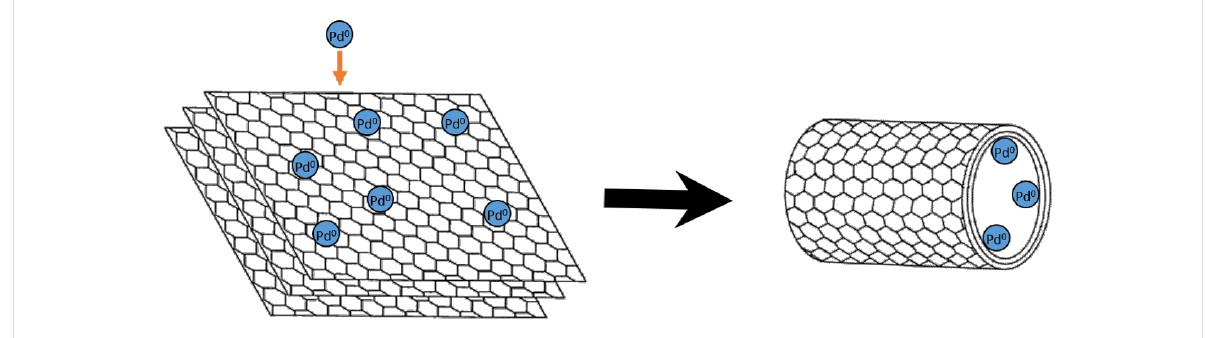
Figure 2: Schematic of a method for producing filled SWCNTs and MWCNTs via arc discharge in solution. Metallic palladium particles decorated the exterior surface of graphene sheets, which were then processed as filled CNTs. This schematic was inspired by a figure appearing in reference [106].